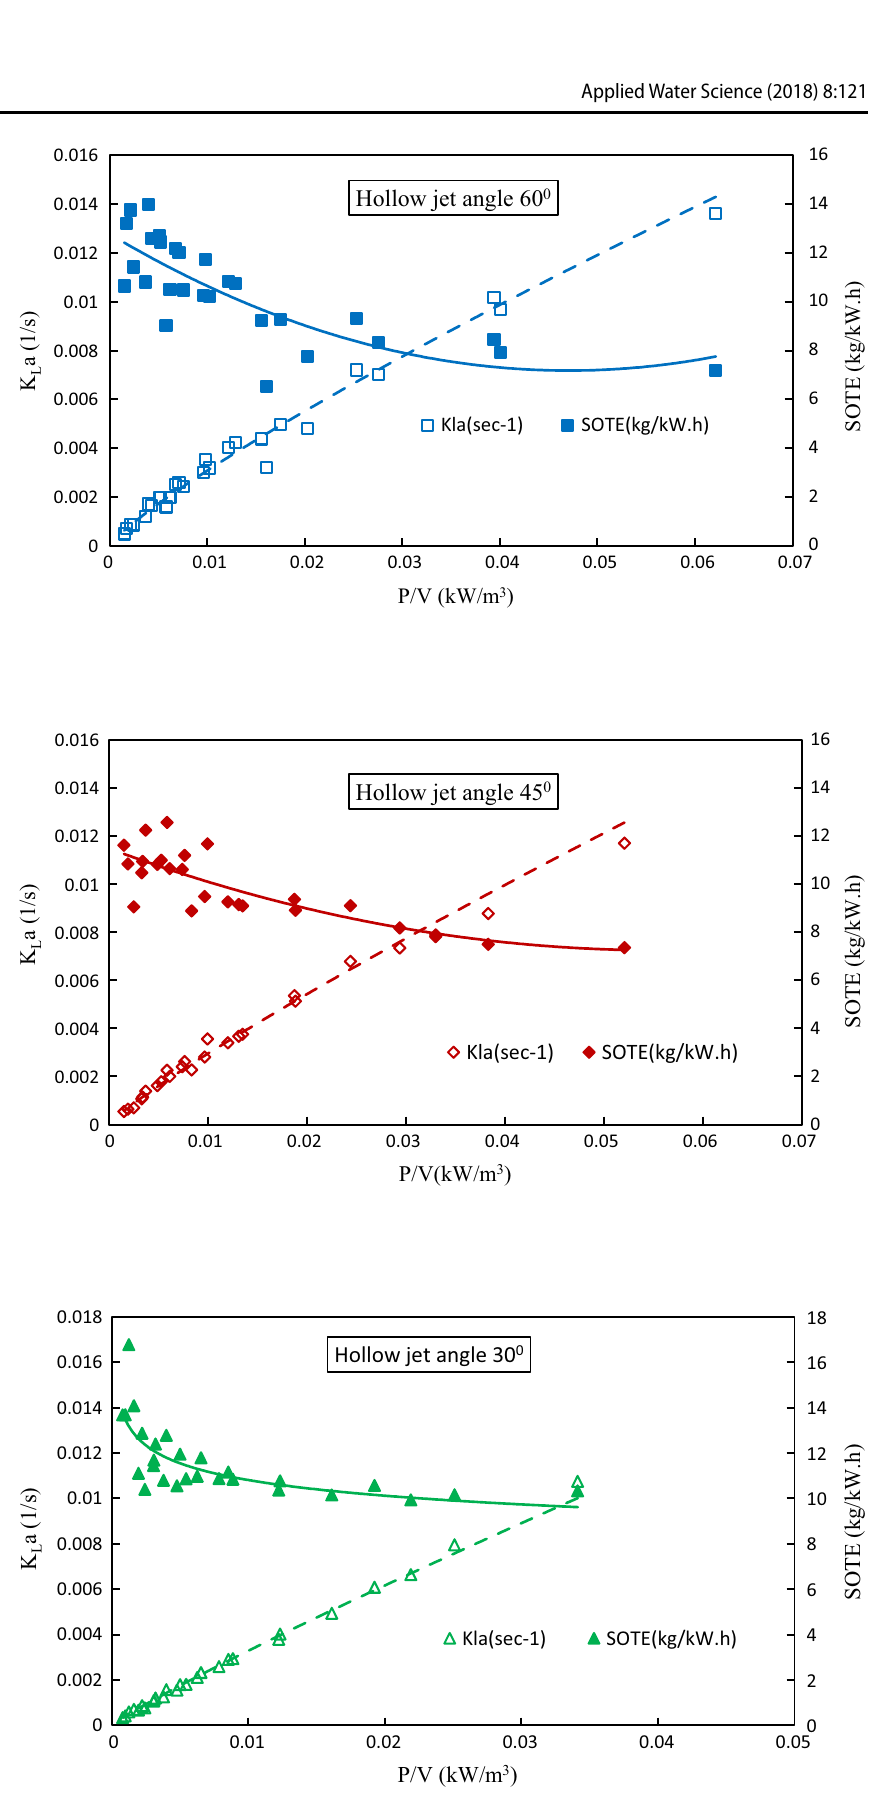
Fig. 4 K L a and SOTE as a func- tion of kinetic jet power per unit volume ( P / V ) of water ( θ = 60°)